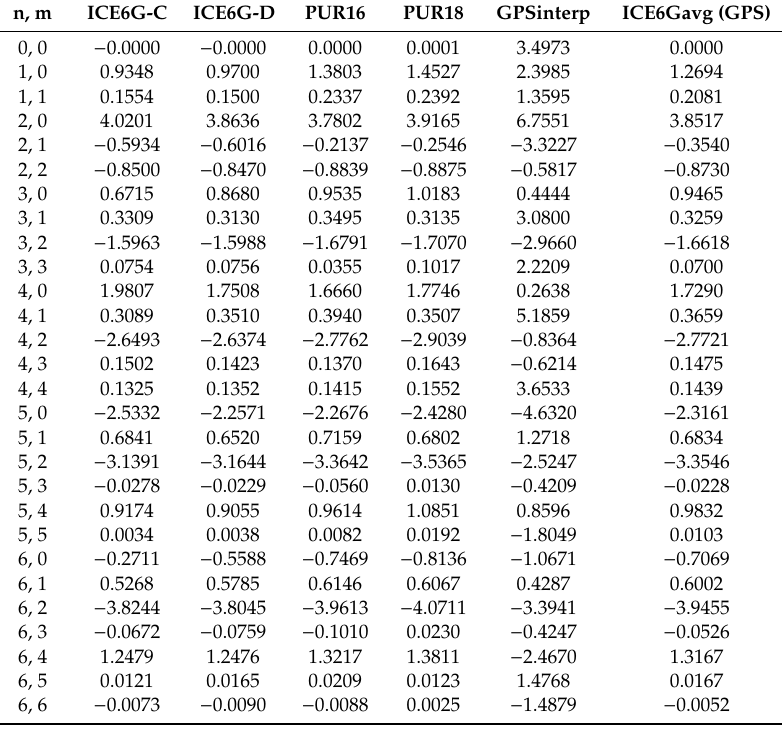
. c X nm of the uplift rates (Unit: 10 − 11 yr − 1 ) 1 .